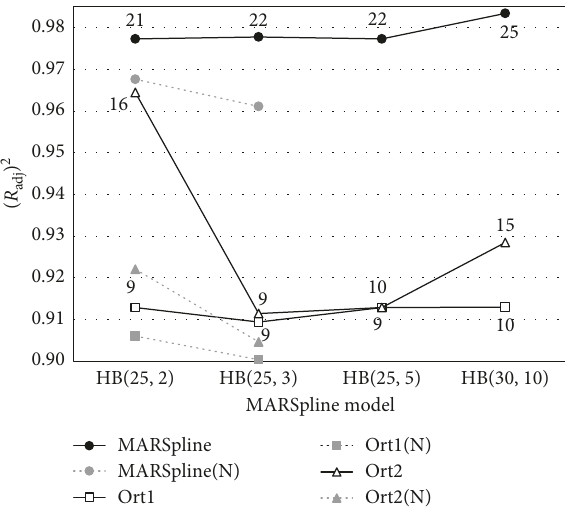
Figure 5: Results of predicting the values of the HB descriptor, based on a series of HB( b , i ) MARSplines models. Notation is the same as in Figure